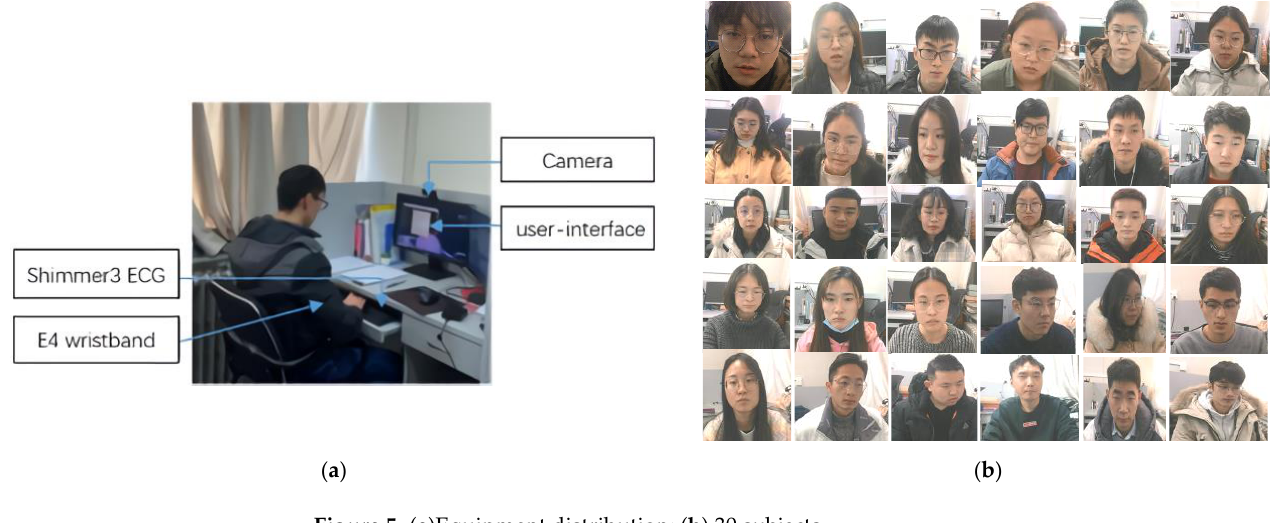
Figure 5. ( a )Equipment distribution; ( b ) 30 subjects.